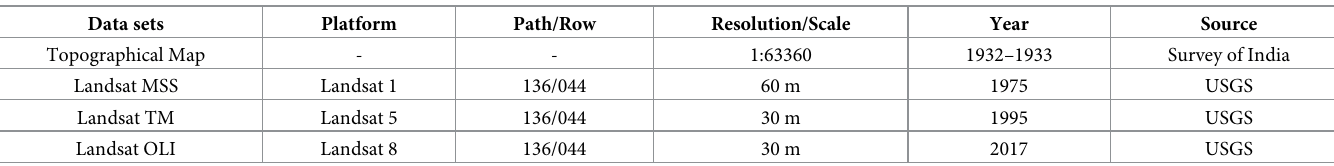
Table 2. Basic information of satellite imageries used for the